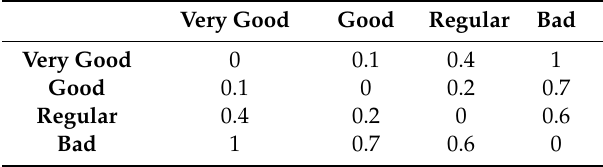
Table 3. Comparison criterion for feature “work quality”.